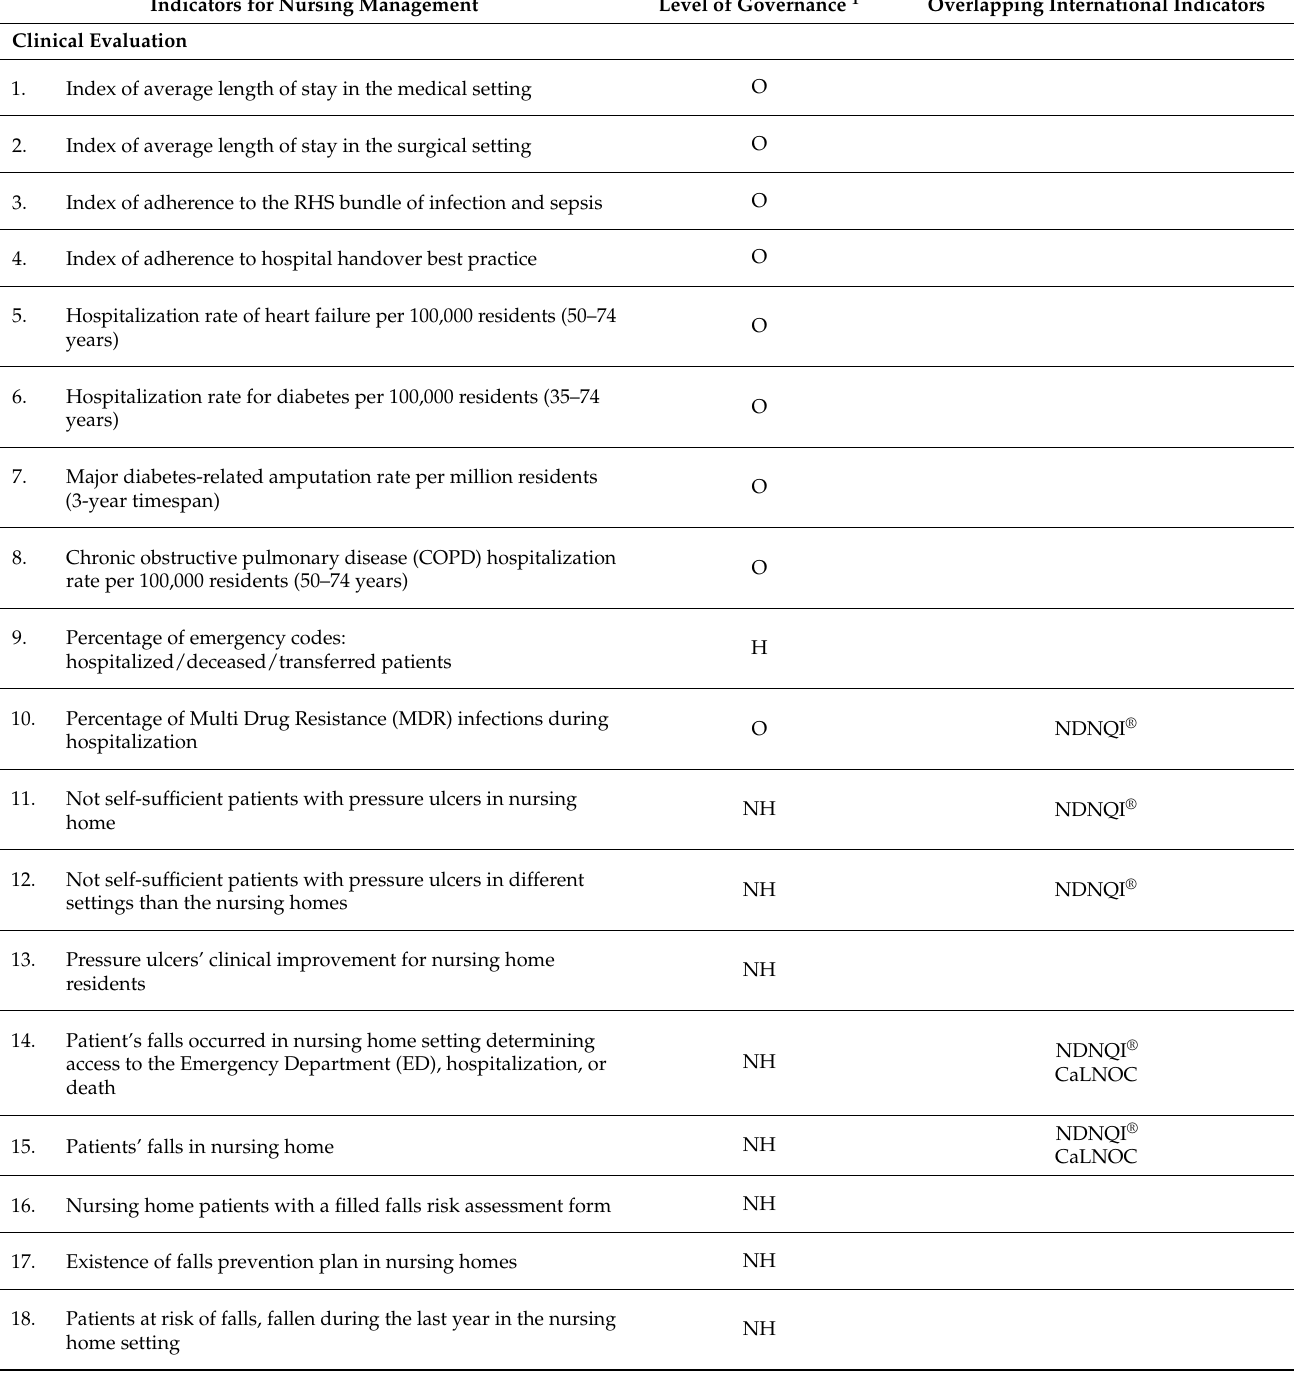
Table 1. The 56 nursing indicators’